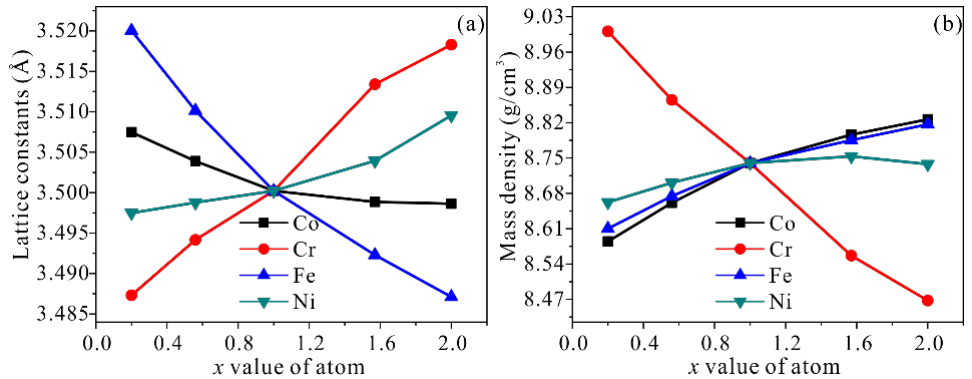
Figure 3. ( a ) Lattice constants and ( b ) mass density of Co-Cr-Fe-Ni HEAs with the x value of ele- ments.